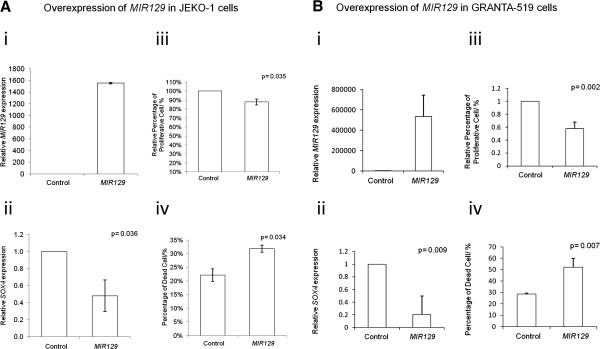
Ectopic re-expression of MIR129 inhibit cell proliferation and elicited cell death in JEKO-1 and GRANTA-519 cells. (A) JEKO-1. (B) GRANTA-519. (i) RT-qPCR analysis of mature MIR129 after 48hrs of transfection of lymphoma cells. (ii) RT-qPCR analysis of the SOX4 expression upon MIR129 overexpression. (iii) Cell proliferation of lymphoma cells in response to overexpression of MIR129 measured by MTT assay. (iv) Percentage of dead cells in response to MIR129 overexpression measured by trypan blue exclusion method. Error bars represent standard deviation.